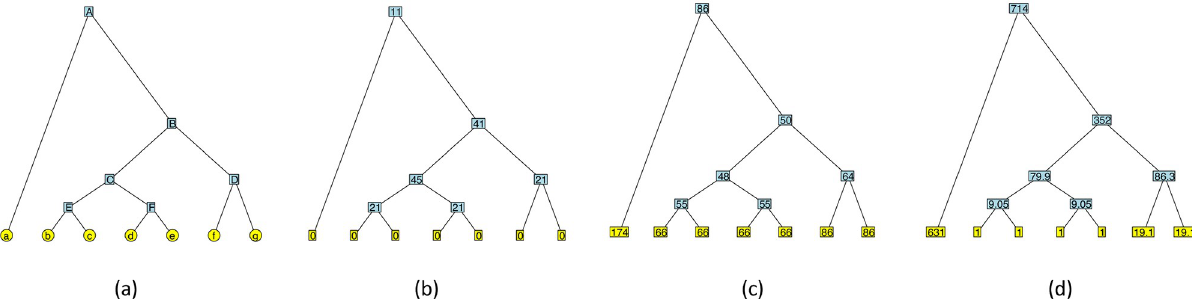
Fig 1. (a) An example tree. In the epidemiological context, tips ( a − g ) would correspond to pathogen sequences and internal nodes ( A − F ) to their inferred common ancestors. Node D subtends a “cherry” configuration, and node C subtends two cherries (a “double cherry”). The heights of the internal nodes are 1 ( E , F ), 2 ( C , D ), 4 ( B ) and 8 ( A ), so the diameter is 16 and the Wiener index is 484, for a mean path length of 6.21. (b) Same tree with betweenness centrality values at each node (note that branch lengths do not change them). The tree has betwenness centrality 45. (c) Same tree with farness (reciprocal of closeness centrality) values at each node. The tree has closeness centrality 1/48. (d) Same tree with eigenvector centrality values (scaled to have a minimum of 1) at each node, rounded to 3 significant figures. Here, the leading eigenvalue is λ = 9.05. By our definition, the tree has eigenvector centrality 714/1023 = 0.698 (here, 1023 2 is the sum of the squared values).